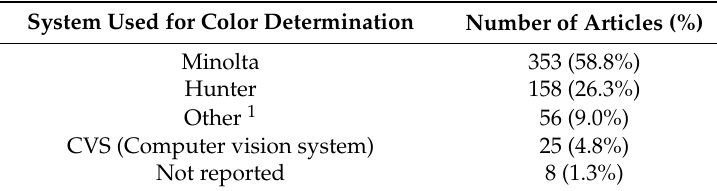
Table 3. Data for color